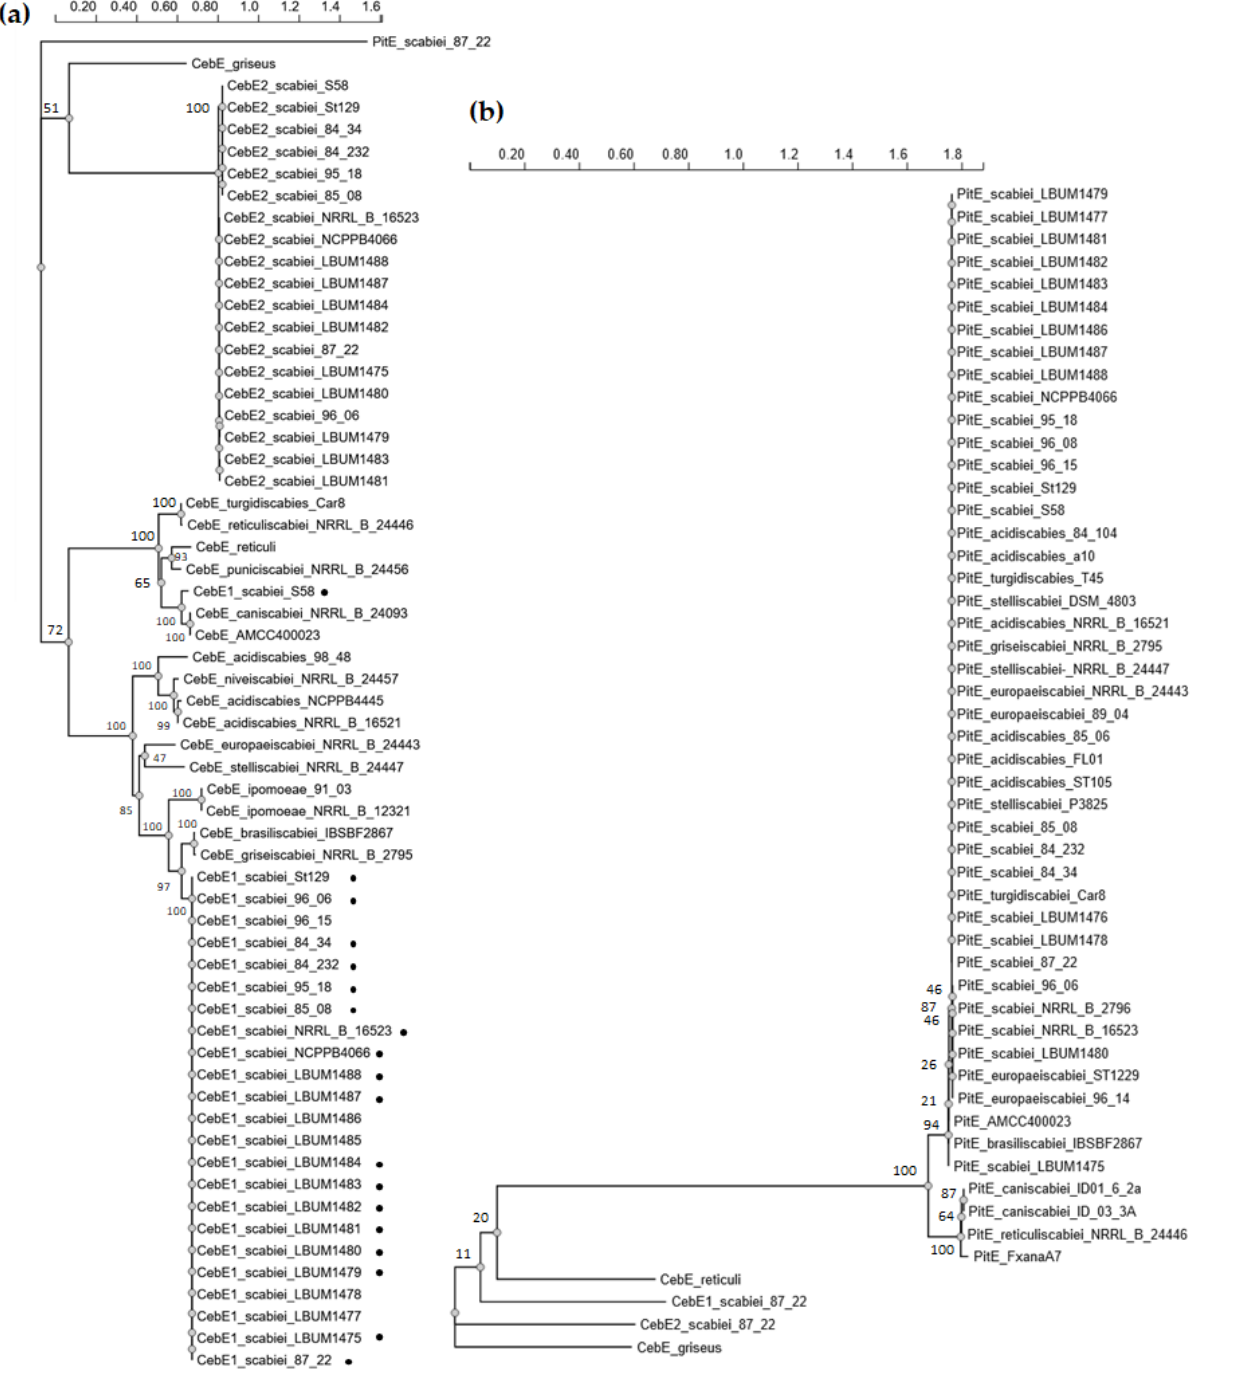
Figure 2. Phylogenetic analysis of CebE and PitE homologues. ( a ) Phylogram with CebE1 and CebE2 homologues. Black dots indicate the strains that possess both CebE1 and CebE2 proteins. Except for S . scabiei strains, only one representative of proteins with identical accession numbers was used to generate the tree; ( b ) Phylogram of PitE homologues. Bootstrap values of main nodes are indicated. The scale bar indicates the number of amino acid sequence substitutions per site. All accession numbers of proteins used to generate the phylograms are listed in Table A2 in Appendix A.